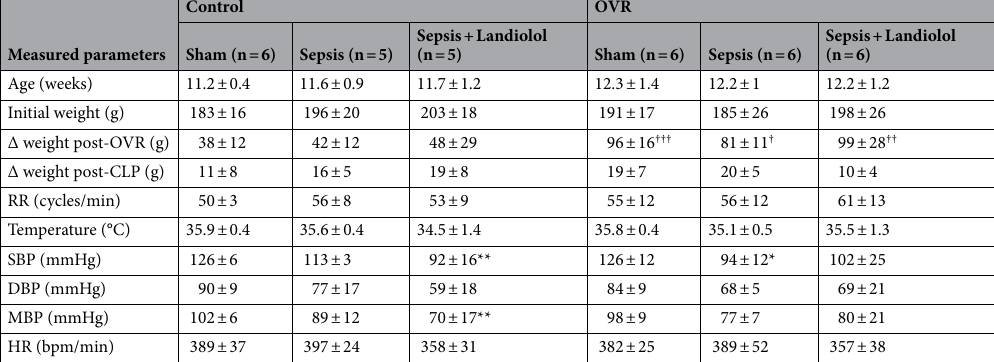
Table 1. Physiological and hemodynamic parameters 18 h after CLP. Age age at the time of CLP, ∆ weight post-OVR weight difference between OVR and CLP procedures, ∆ weight post-CLP weight difference between CLP and 18 h after, RR respiratory rate, SBP systolic blood pressure, DBP diastolic blood pressure, MBP mean blood pressure, HR heart rate. Data are expressed as means ± SD. † p < 0.05; †† p < 0.01; ††† p < 0.001 vs control of corresponding group. *p < 0.05; **p < 0.01 vs control sham and vs OVR-sham, respectively.